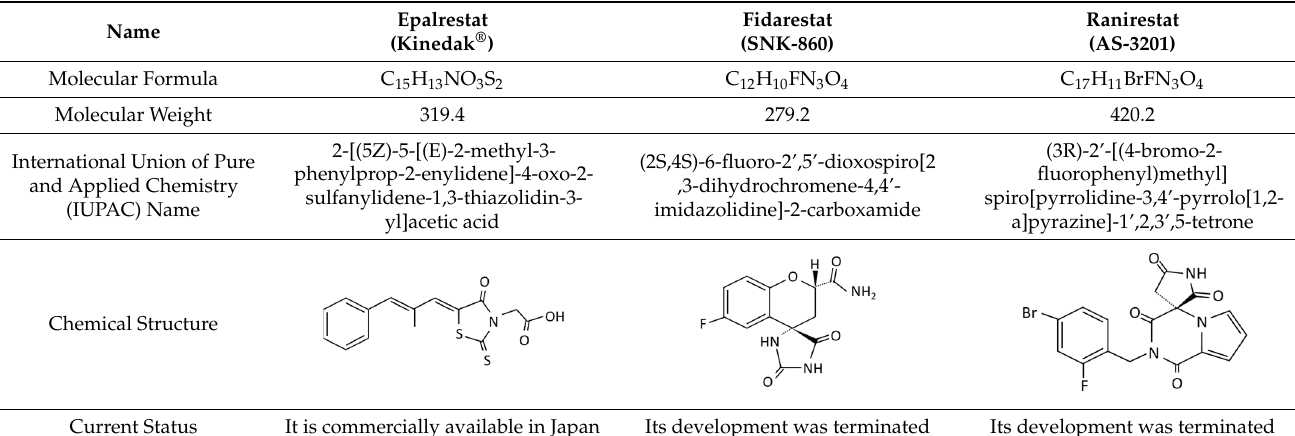
Figure 1. Glucose metabolism and the polyol pathway in the peripheral nervous system. Under normoglycemic conditions ( a ), most of the glucose incorporated into the cells via glucose transporters (GLUT) is metabolized into pyruvate through the glycolytic pathway, and less than 3% of the glucose enters the polyol pathway. However, under hyperglycemic conditions ( b ), the escalation of glucose flux into the polyol pathway results in the accumulation of sorbitol and fructose and the consumption of cofactors of AR (NADPH) and SDH (NAD + ). Increased sorbitol contents lead to the depletion of myo- inositol and taurine, and reduced myo-inositol contents can be a cause of decreases in phosphoinositide and diacylglycerol. Red and blue arrows indicate increases and decreases in the amount of molecules, respectively. Table 1. Aldose reductase inhibitors described in this article.